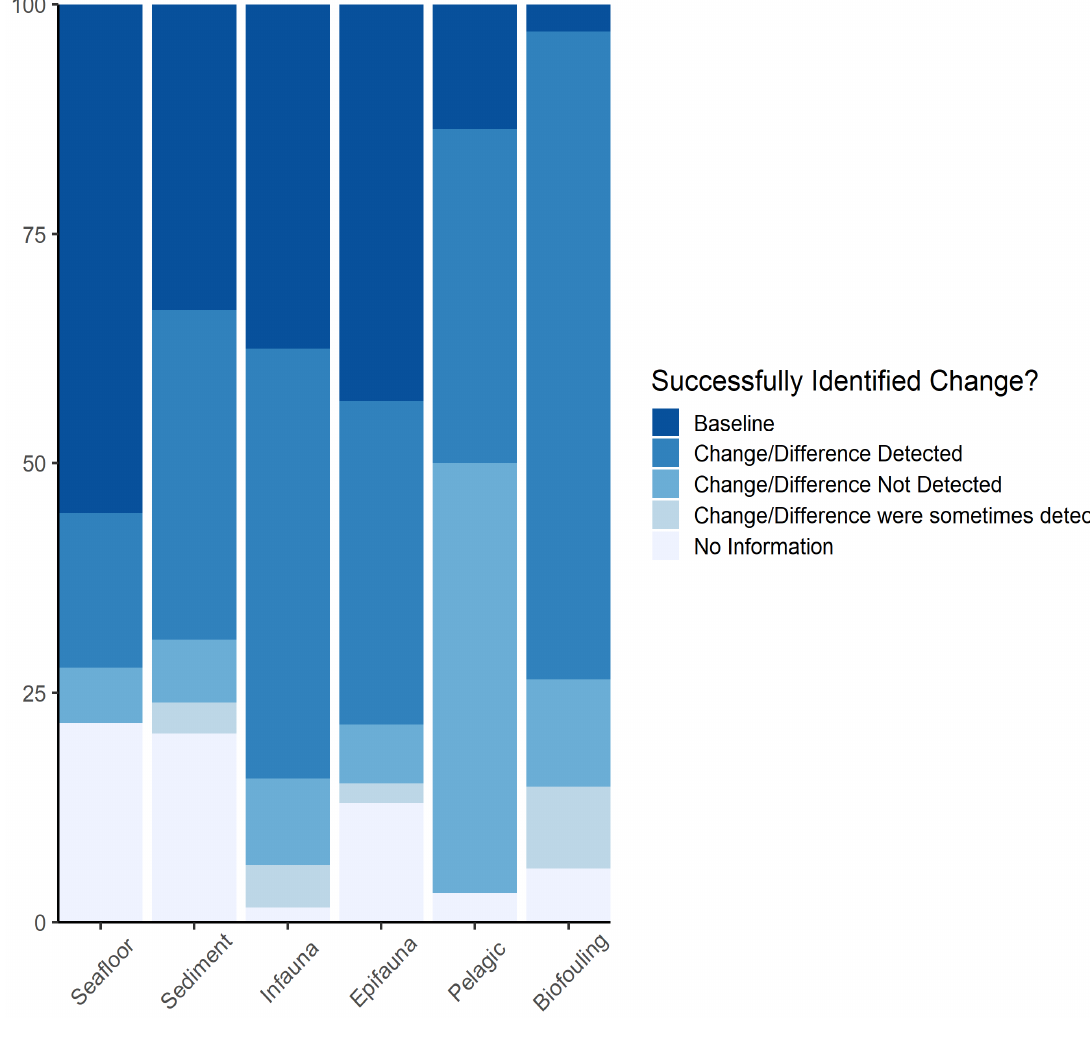
Figure 5. Success, within the reviewed studies, in detecting changes or differences in habitats, within the survey area or before/after an event susceptible to trigger changes. the survey area or before/after an event susceptible to trigger